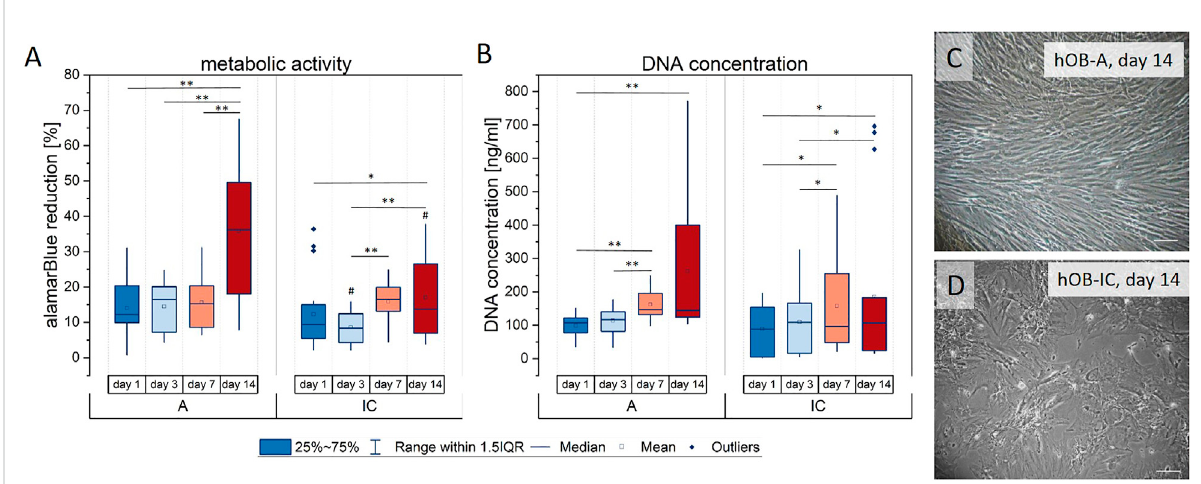
FIGURE 1 Proliferation of human osteoblasts derived from alveolar bone (hOB-A) and matched iliac crest (hOB-IC) of the same donor (6 donors) in expansion medium. The proliferation capacity was determined by (A) the metabolic activity given by the reduction of the reporter dye alamarBlue in the mitochondrial respiratory chain (metabolic activity is given as percentage of a 100% reduced control) and (B) the DNA concentration that is proportional to the cell number at days 1, 3, 7 and 14. (C,D) Bright fi eld micrograph of hOB-A and hOB-IC after 14 days 2D-monolayer culture. * p < 0.05 and ** p < 0.01 for comparison between culture days; # p < 0.05 for comparison between hOB-A and hOB-IC at the corresponding time point; Wilcoxon signed-rank test, n = 6. Scale bars: 100